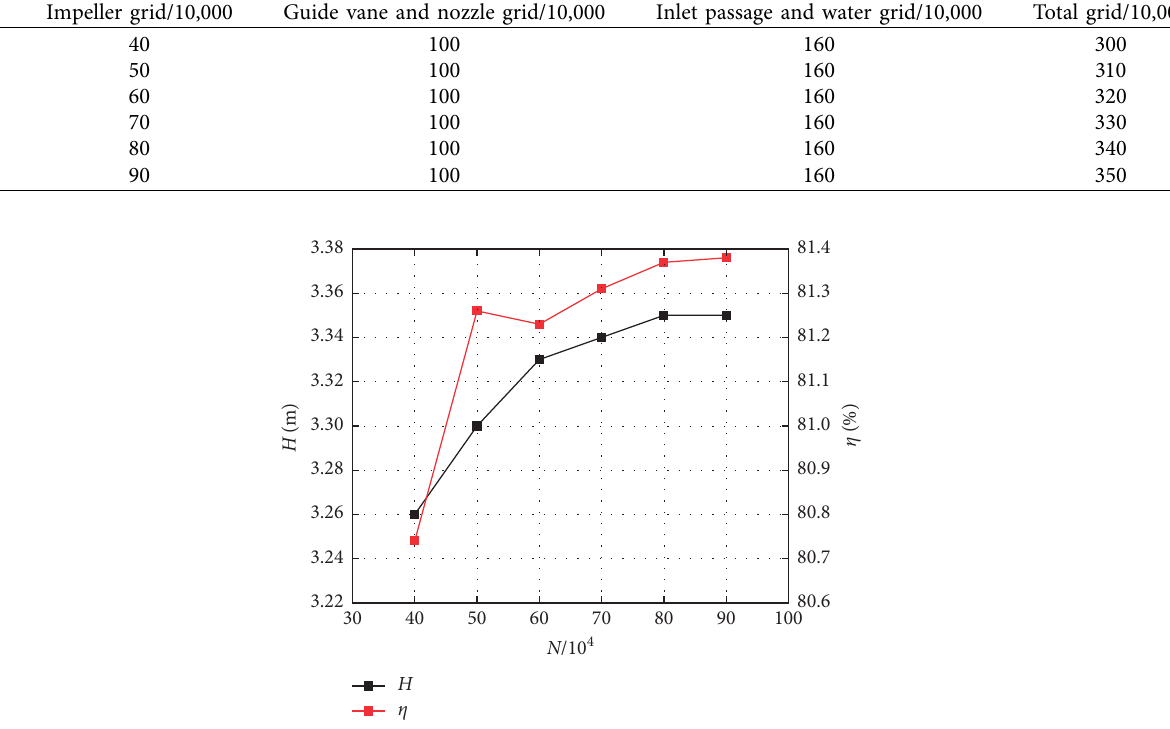
Figure 4: Grid independence